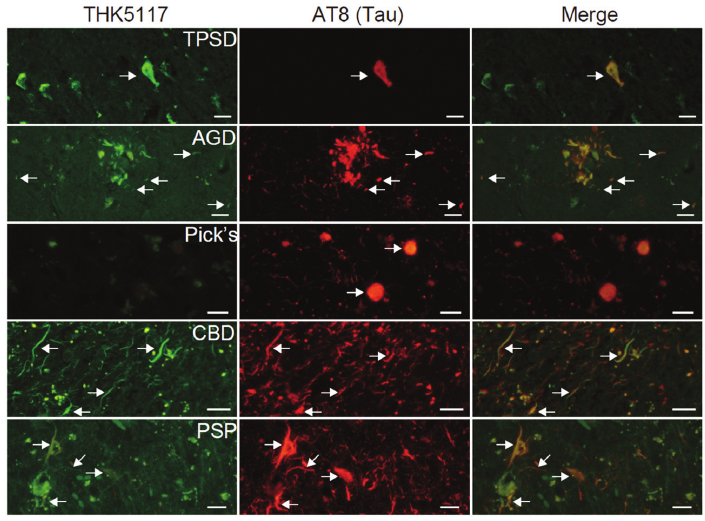
Figure 4. Fluorescence staining of THK5117 in various tauopathies such as tangle predominant senile dementia (TPSD), argyrophilic grain disease (AGD), Pick’s disease, corticobasal degeneration (CBD), and progressive supranuclear palsy (PSP). Scale bar: 20 µ m. Arrows indicate the same tau deposits for each brain sample.